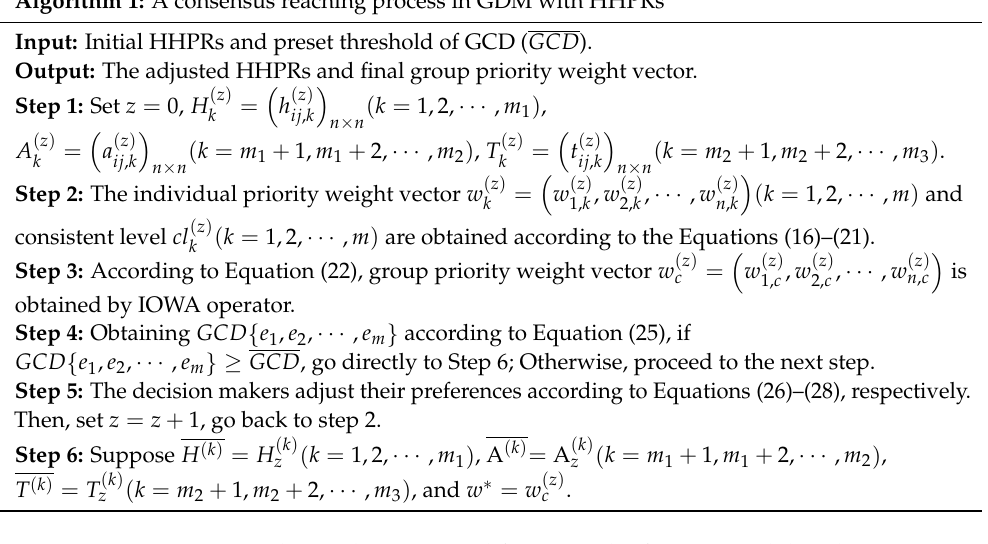
Algorithm 1: A consensus reaching process in GDM with HHPRs